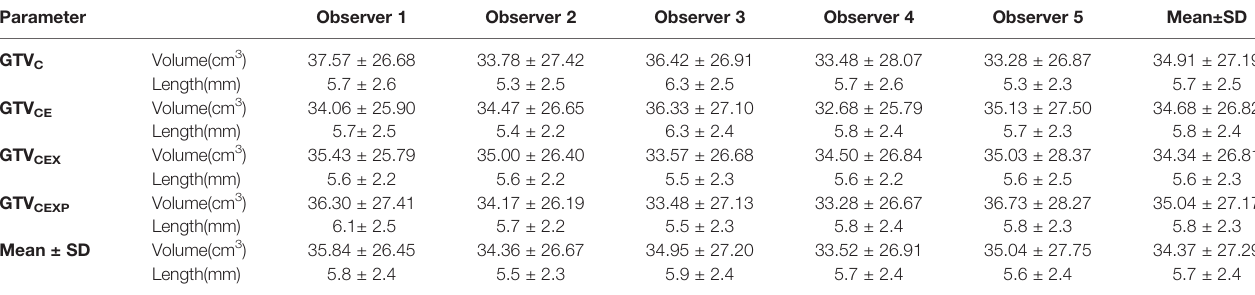
TABLE 2 | The volume and longitudinal length of GTVs based on different combinations of multimodal imaging for different observers.